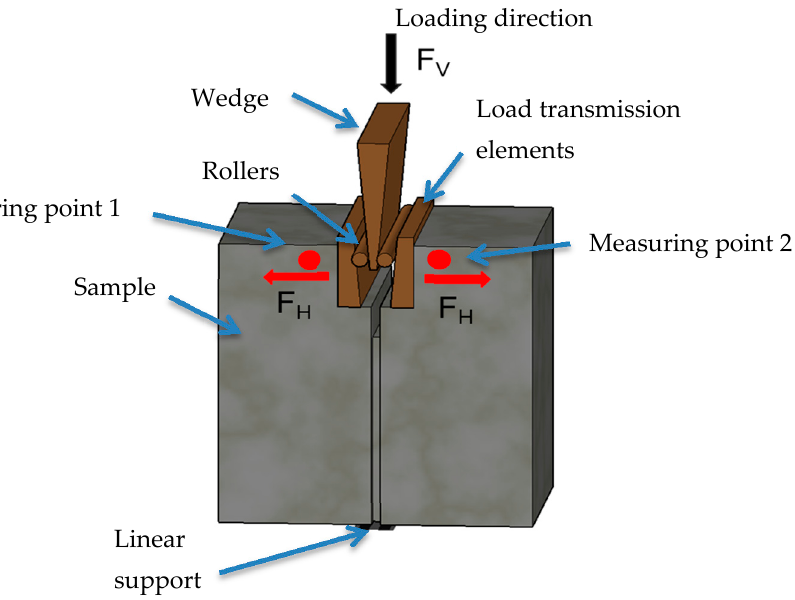
Figure 1. Schematic representation of the wedge-splitting test.